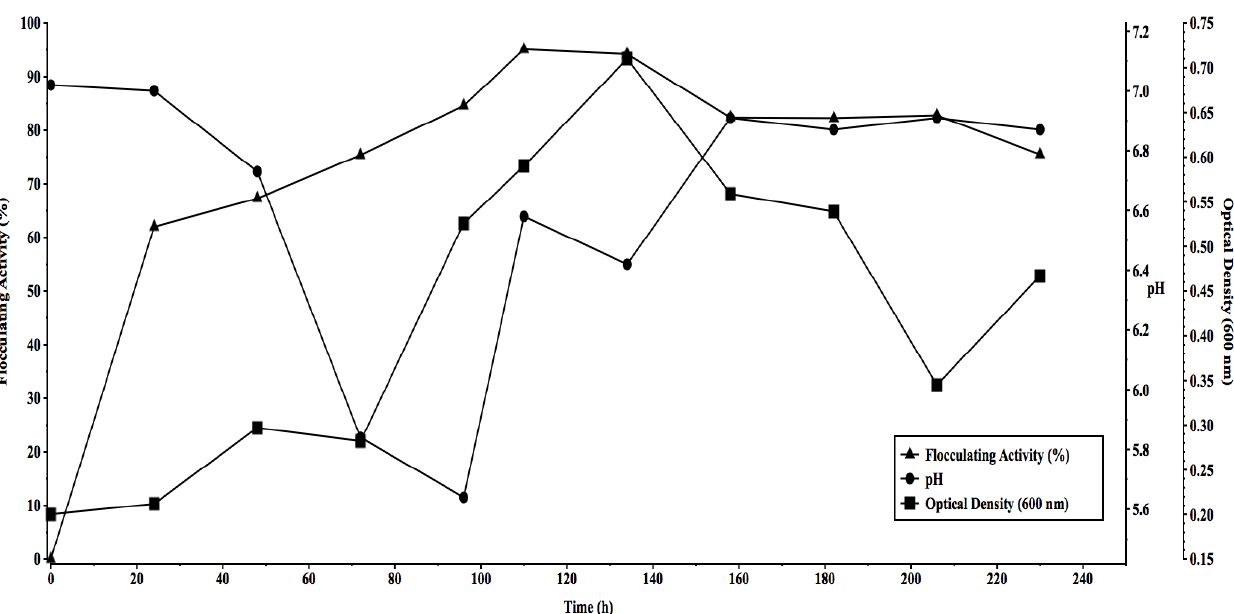
Figure 2. Time course assay of flocculant production by by Halomonas sp. OKOH.